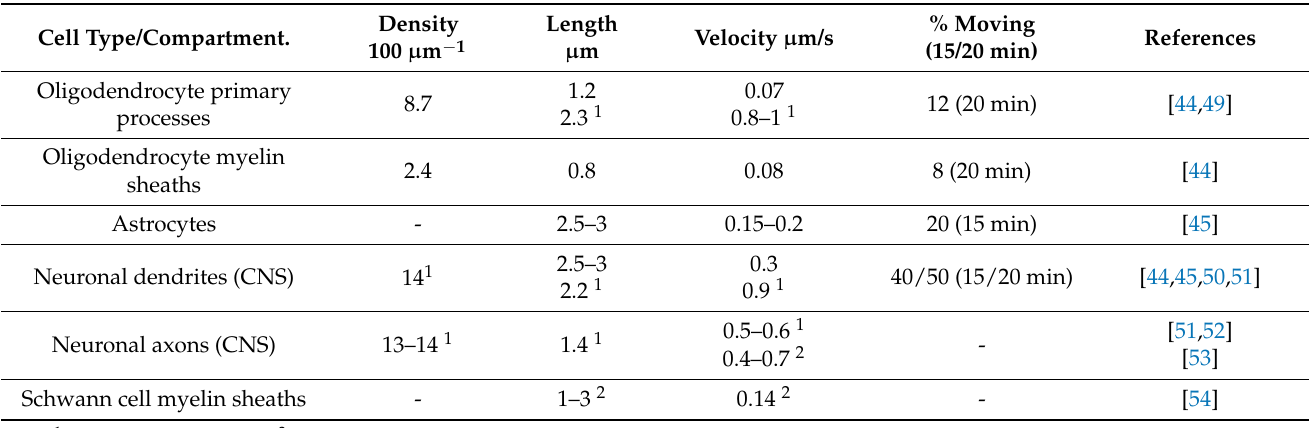
Table 1. Density, length, and mobility of mitochondria in different cell types and compartments of the nervous system. Cell